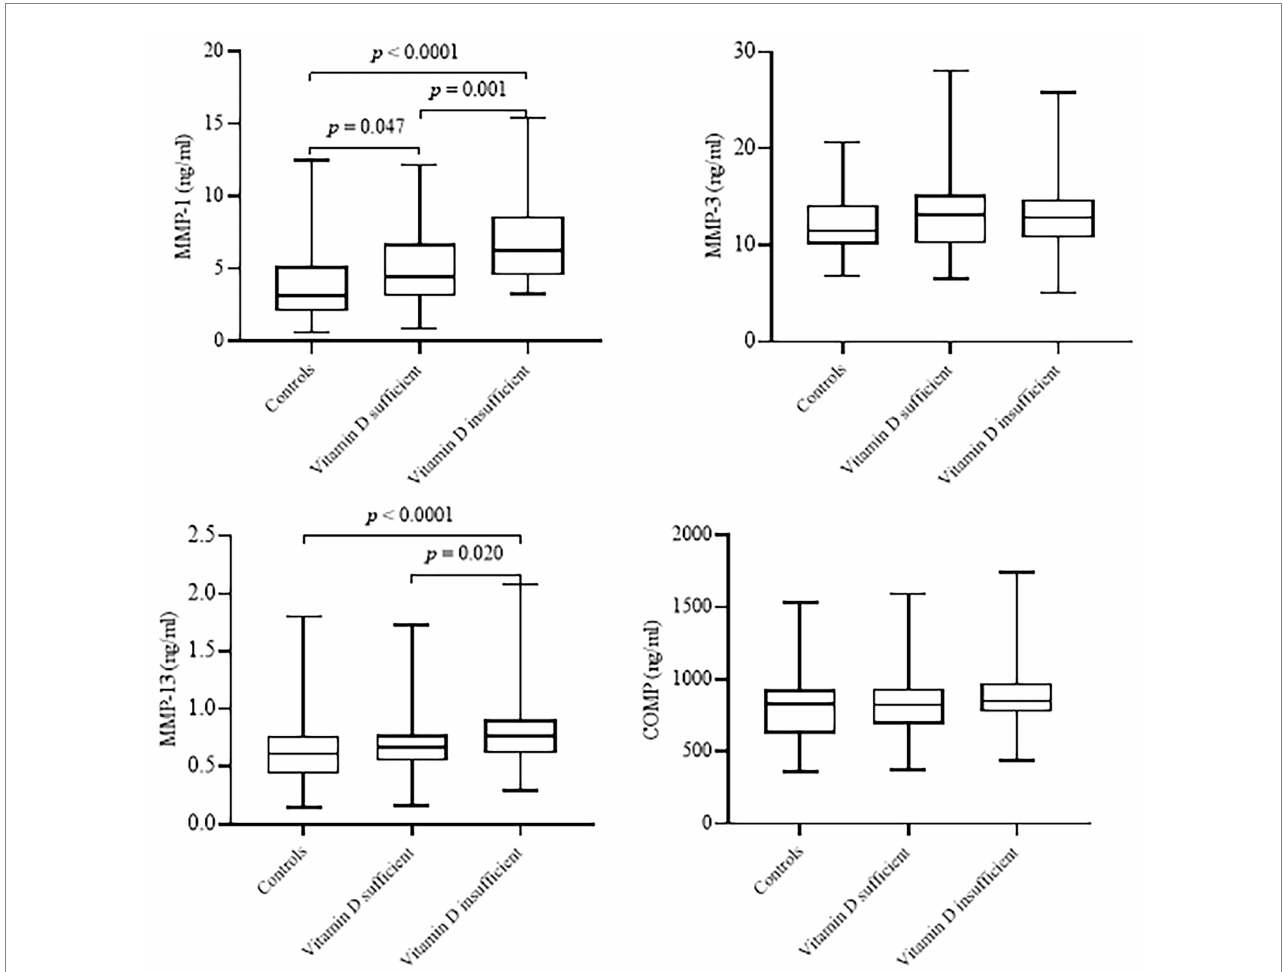
FIGURE 1 Serum concentrations of matrix metalloproteinases (MMP-1, MMP-3, and MMP-13) and cartilage oligomeric matrix protein (COMP) of healthy controls and patients with knee osteoarthritis according to vitamin D status. Healthy control group, n = 65; vitamin D sufficient group, n = 60, vitamin D insufficient group, n = 64. Vitamin D sufficient and insufficient was defined as serum 25(OH)D concentrations ≥ 30 ng/mL and serum 25(OH)D concentrations <30 ng/ mL, respectively. Data are shown as median (interquartile range). P -values obtained from Kruskal-Wallis test. P < 0.05 was considered